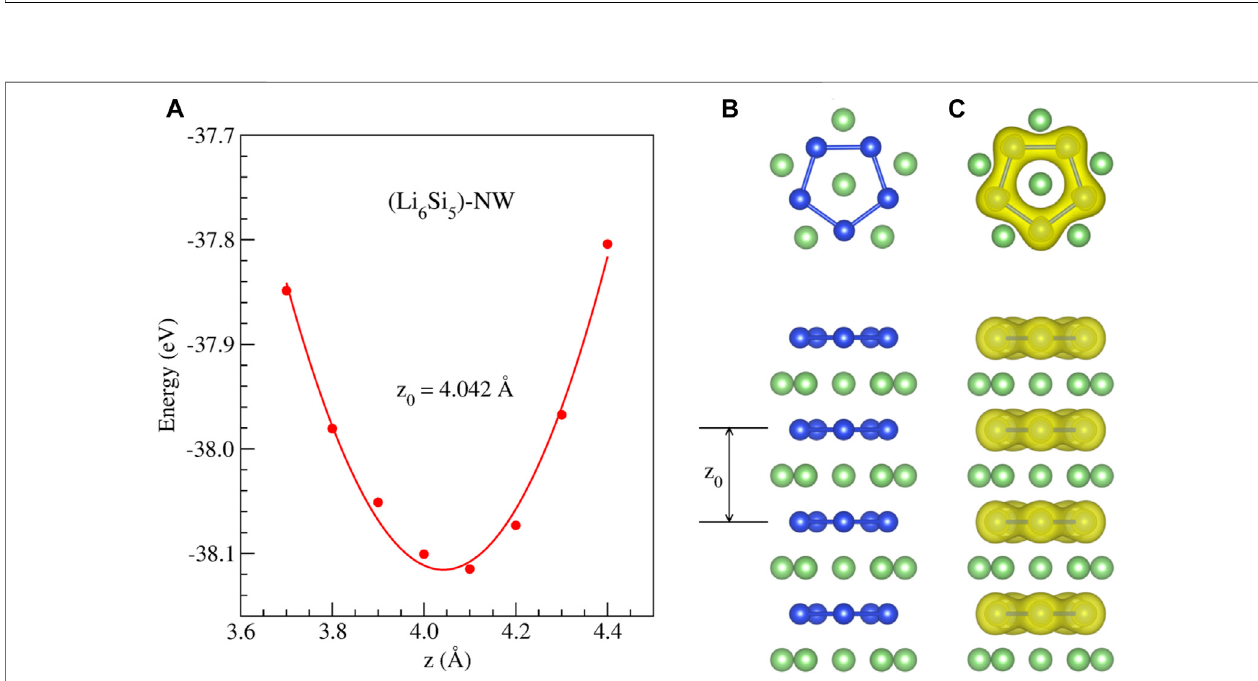
FIGURE 2 | Stability of the 1 ∞ [ Li 6 Si 5 ] isolated model (Li 6 Si 5 -NW) obtained from periodic DFT calculations: (A) Energy as a function of the distance between Li 6 Si 5 units, (B) top and side views of the equilibrium geometry, (C) electronic density distribution for the isosurface at 0.05 e /A ˚ 3 .